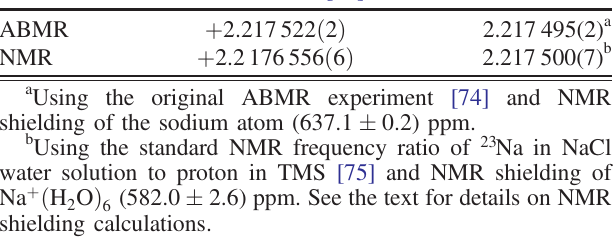
Based on our improved ratio of μ ð 26 Na Þ = μ ð 23 Na Þ